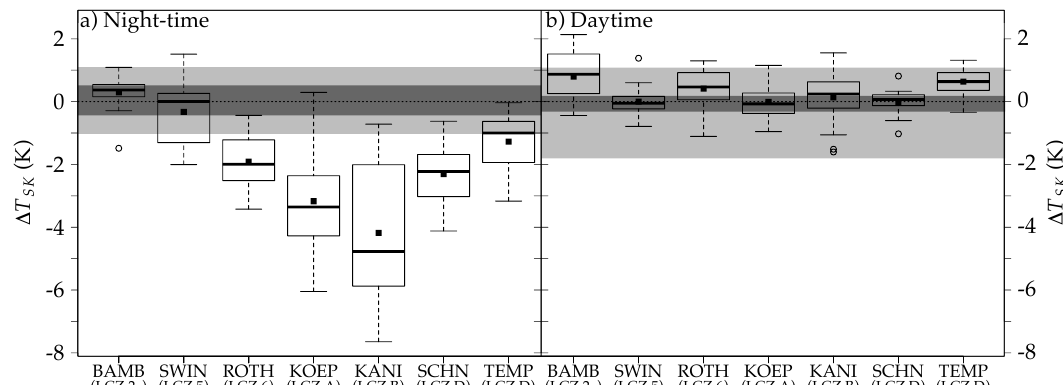
Figure 7. Air temperature ( T ) differences ( ∆ T SK ) in various local climate zones (LCZs) in Berlin from the spatial mean T across all sites within the study area Schillerkiez for 22 nights (left panel) and 22 days (right panel). The bold black line in each box shows the median, the black square the arithmetic temporal mean. Boxes include data points that are between the 1st and the 3rd quartile (interquartile range IQR). The whiskers show the remaining data points, maximum length is 1.5 times the IQR below the 1st and above the 3rd quartile. Data points outside of this are depicted as circles. Grey areas depict the range between the highest and lowest ∆ T SK among all sites within the Schillerkiez for all nights and days (light grey) and the range between the highest and lowest temporal mean sites across all 22 nights and days (dark